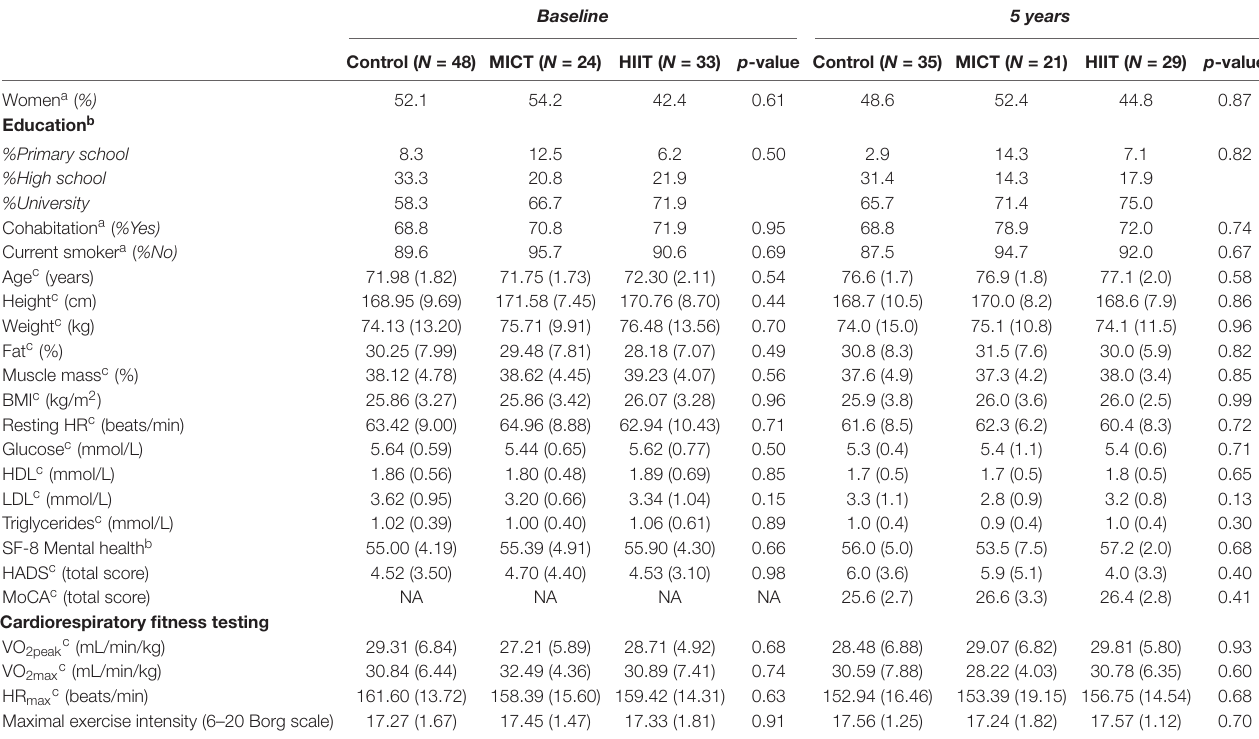
TABLE 1 | Demographics, clinical, and cognitive data for the control group, moderate-intensity continuous training (MICT), and high-intensity interval training (HIIT) at baseline and at the end of intervention at 5-year follow-up. Baseline 5